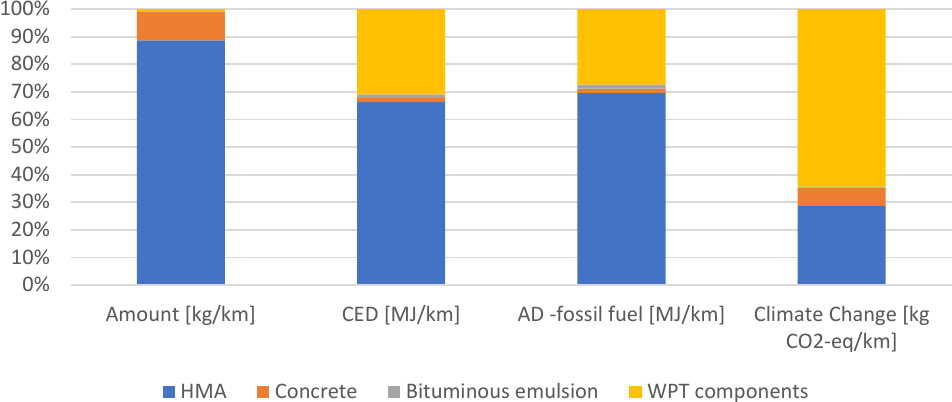
Figure 6. The e-road materials and components: Impacts and weights per km.